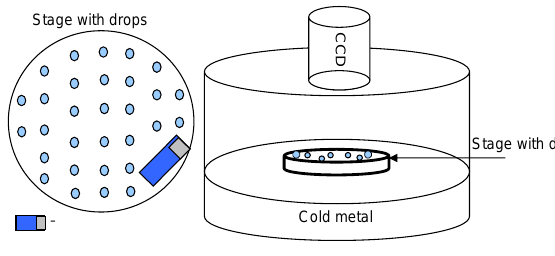
Fig.2: Schematic diagram of the immersion freezing method. Fig. 2. Schematic diagram of the immersion freezing method.